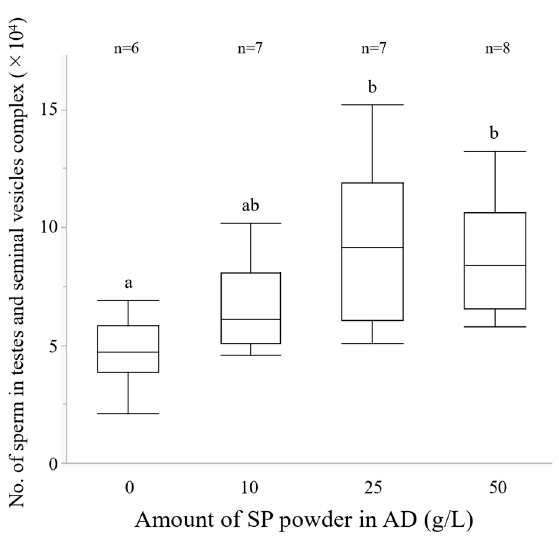
Figure 7. Relationship between the amount of sweet potato powder and the number of sperm in testes-seminal vesicles complexes. Boxplots represent medians (thick lines), the first and third quartile ranges (box perimeters), minimum and maximum (whiskers). The diet of the larvae significantly affected the number of sperm in the testes-seminal vesicles complex (GLM; L-R χ 2 = 11.81, p < 0.01). Different letters show significant differences ( p < 0.05).